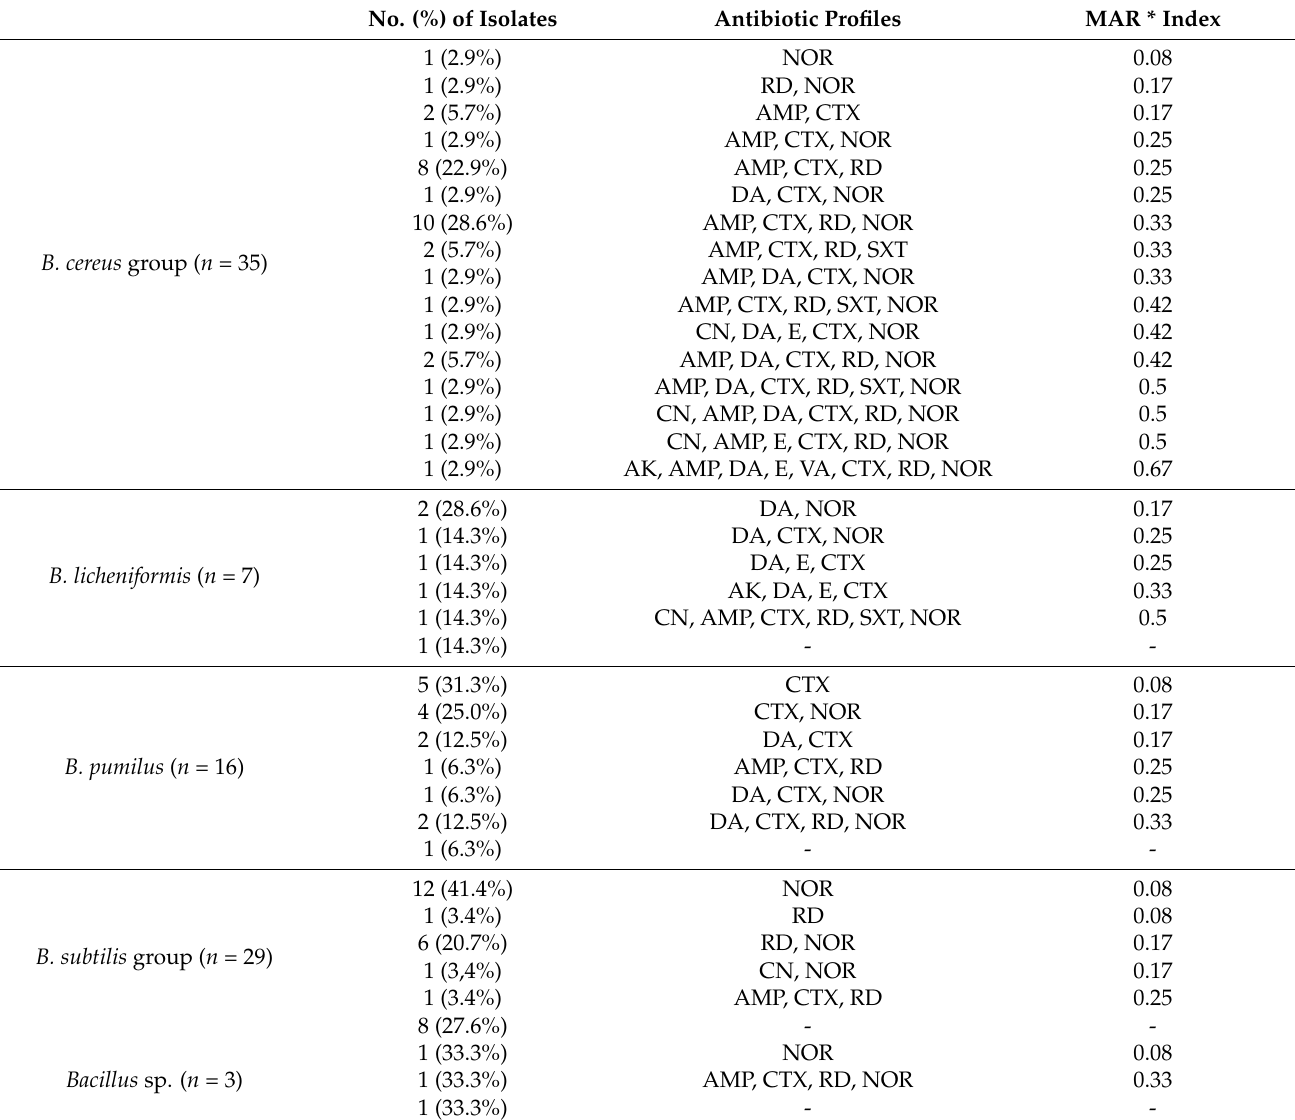
Table 1. Antimicrobial susceptibility profile of Bacillus